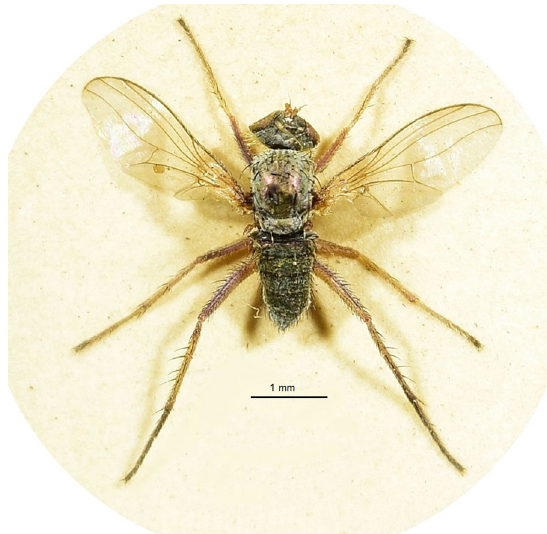
Fig. 8 Thinophilus spinulosus Parent female habitus,